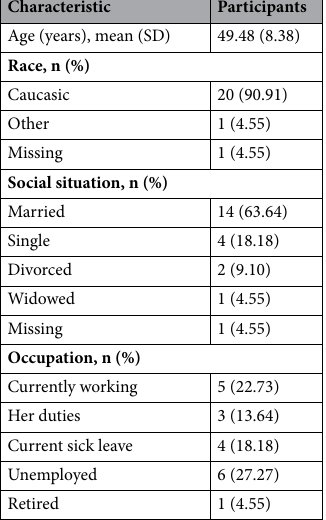
Table 3. Demographic characteristics (N = 22). SD standard deviation.